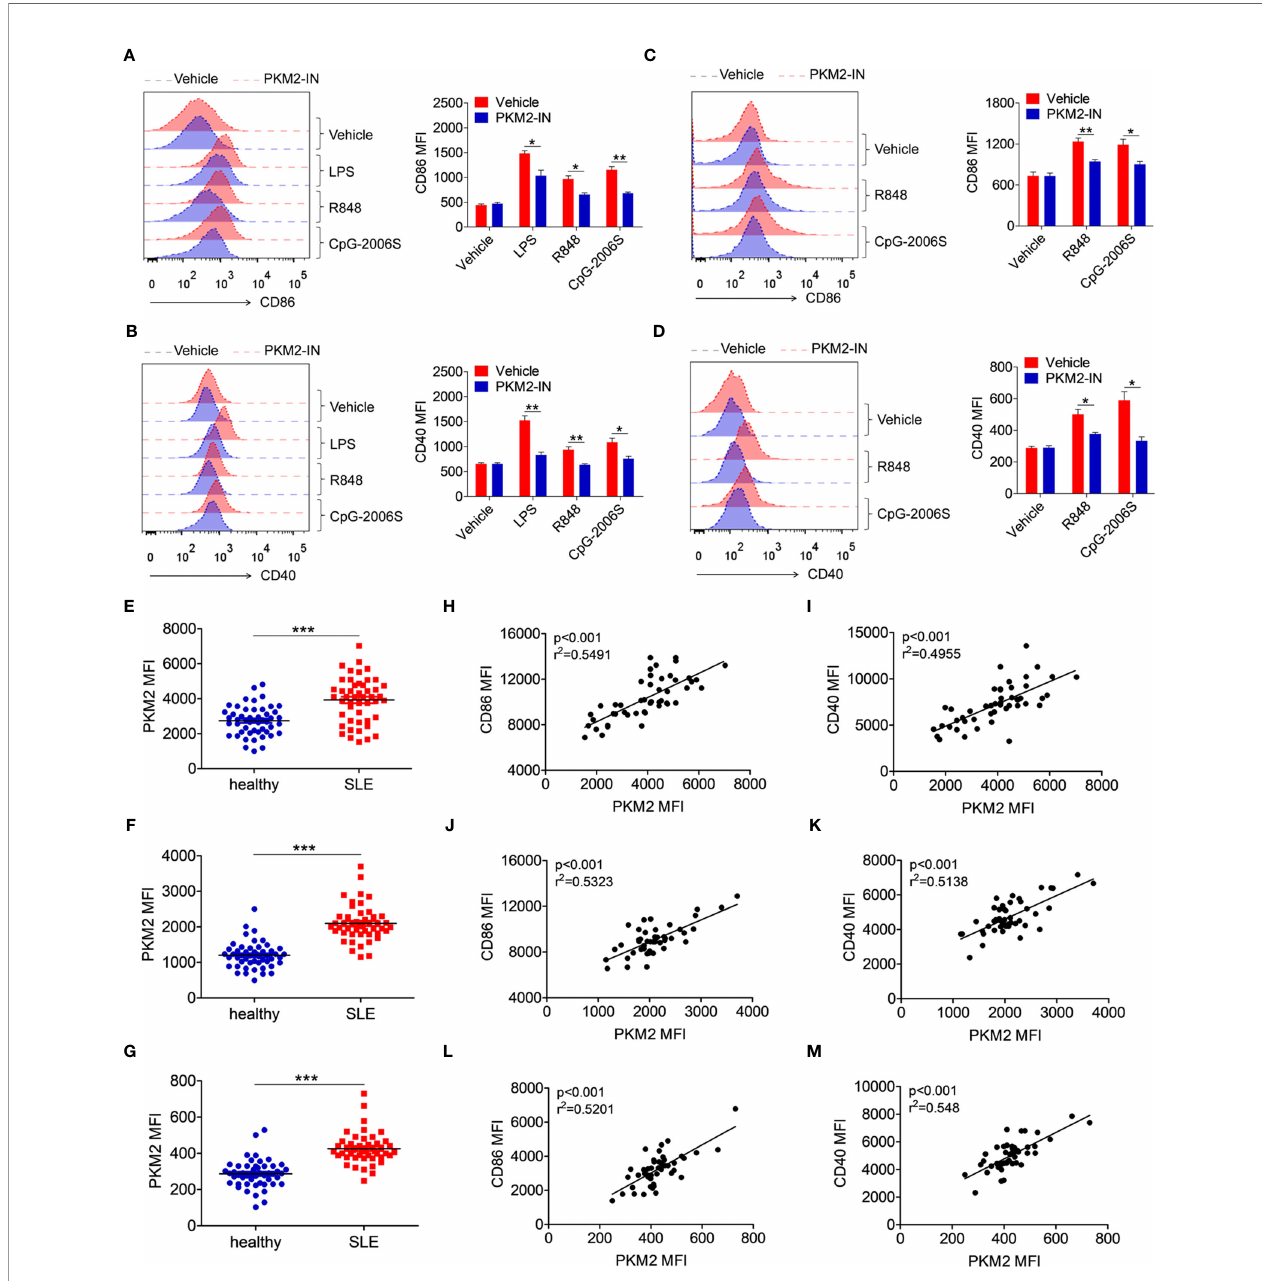
FIGURE 9 | PKM2 is over-expressed in SLE patients and correlated with activation of monocytes, DCs and B cells. (A, B) MDMs, derived from PBMCs from healthy donors, were pretreated with PKM2-IN (5 m M) for 2 hours followed by stimulations of LPS (100 ng/mL), R848 (1 m g/mL) and CpG-2006S (1 m M). FACS analysis of CD86 and CD40 expressions on MDMs at 24 hours. (C, D) CD19 + B cells, isolated from PBMCs from healthy donors, were pretreated with PKM2-IN (5 m M) for 2 hours followed by stimulations of R848 (1 m g/mL) and CpG-2006S (1 m M). FACS analysis of CD86 and CD40 expressions on CD19 + B cells at 24 hours. Data are representative from one out of four biological replicates, each with three technical replicates. Error bars represent S.E.M. (E) FACS analysis of PKM2 protein expression on CD14 + monocytes in PBMCs from SLE patients (n=48) and healthy donors (n=50). (F) Positive correlation between PKM2 and CD86 in CD14 + monocytes from PBMCs of SLE patients (n=48). (G) Positive correlation between PKM2 and CD40 in CD14 + monocytes from PBMCs of SLE patients (n=48). (H) FACS analysis of PKM2 protein expression on CD11c + dendritic cells in PBMCs from SLE patients (n=48) and healthy donors (n=50). (I) Positive correlation between PKM2 and CD86 in CD11c + dendritic cells from PBMCs of SLE patients (n=48). (J) Positive correlation between PKM2 and CD40 in CD11c + dendritic cells from PBMCs of SLE patients (n=48). (K) FACS analysis of PKM2 protein expression on CD19 + B cells in PBMCs from SLE patients (n=48) and healthy donors (n=50). (L) Positive correlation between PKM2 and CD86 in CD19 + B cells from PBMCs of SLE patients (n=48). (M) Positive correlation between PKM2 and CD40 in CD19 + B cells from PBMCs of SLE patients (n=48). Error bars represent S.E.M. * p < 0.05, ** p < 0.01, *** p < 0.001, as determined by ANOVA tests or t -tests. Correlation coef fi cients were calculated using linear regression